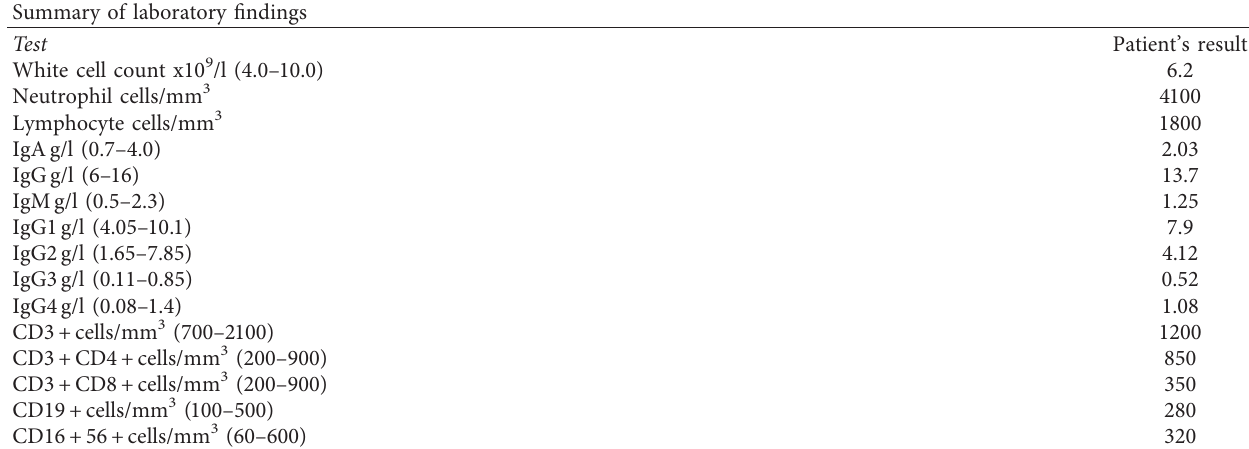
Table 1: Summary of laboratory findings.